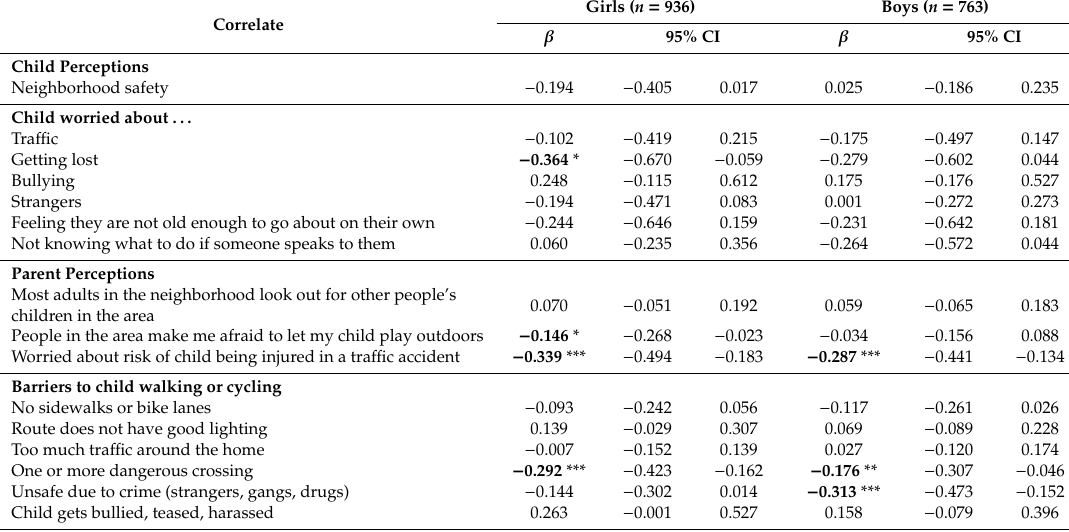
Table 3. Social-environment-level correlates of children’s independent mobility.